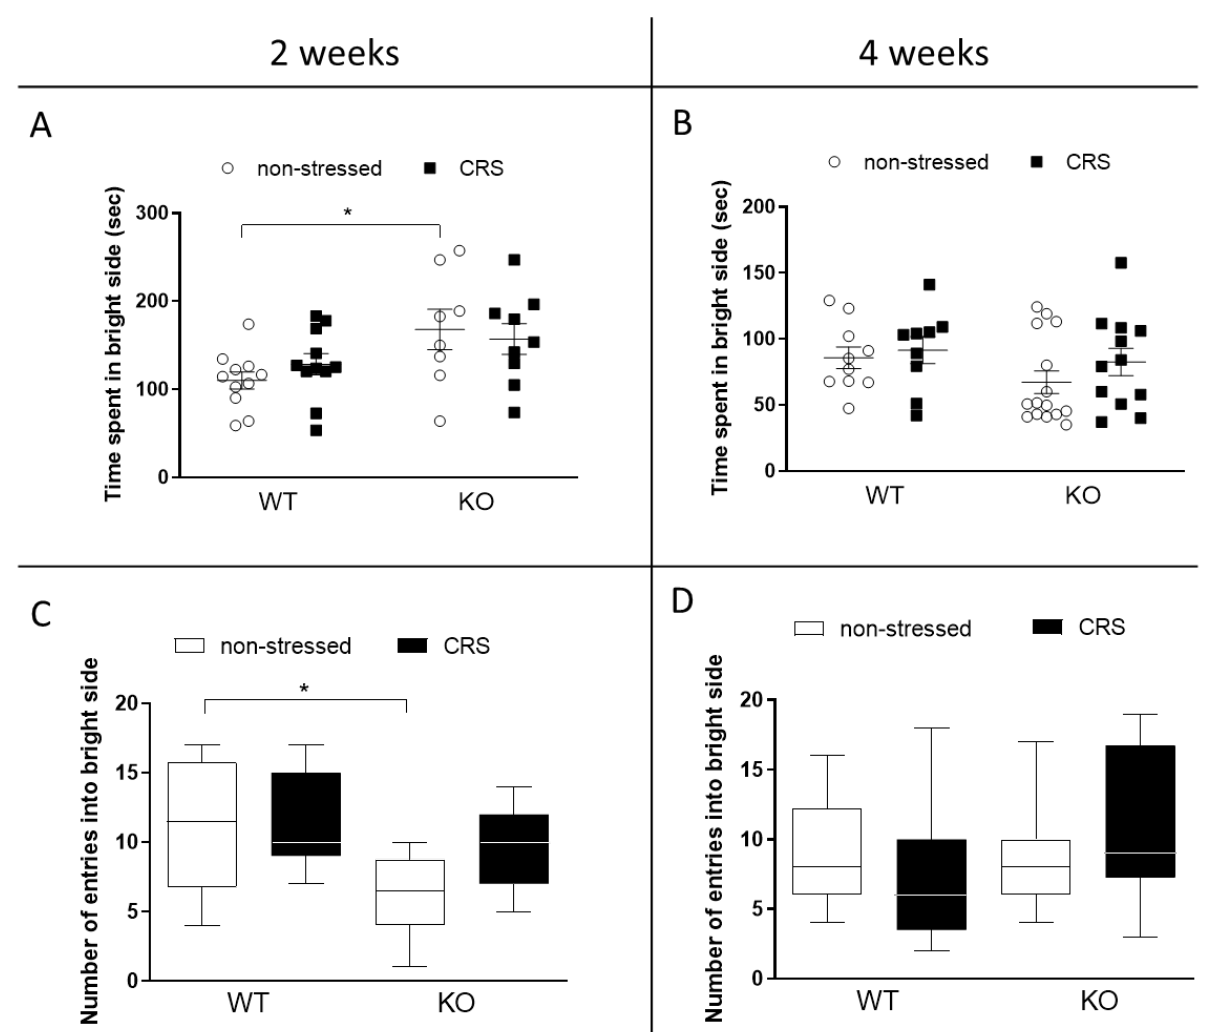
Figure 5. Behavioral alterations induced by chronic restraint stress (CRS) in female wild-type (WT) and Interleukine-1 knock-out (KO) mice detected with the light–dark box test (LDB). Time spent in the lit compartment after 2 weeks ( A ) and after 4 weeks ( B ); the number of entries into the light after 2 weeks ( C ) and 4 weeks ( D ). Data are presented as the means ± SEM in case of A&B (animals with individual plots) and as the median ± IQR in case of C&D ( n = 8–15); two-way analysis of variance (ANOVA), followed by Tukey’s tests; Kruskal–Wallis test, followed by Dunn’s test; * p < 0.05 vs. indicated group. Open Field Test (OFT) Two weeks of stress induced a significant locomotor activity increase in the IL-1 KO animals but not in the WTs (Figure